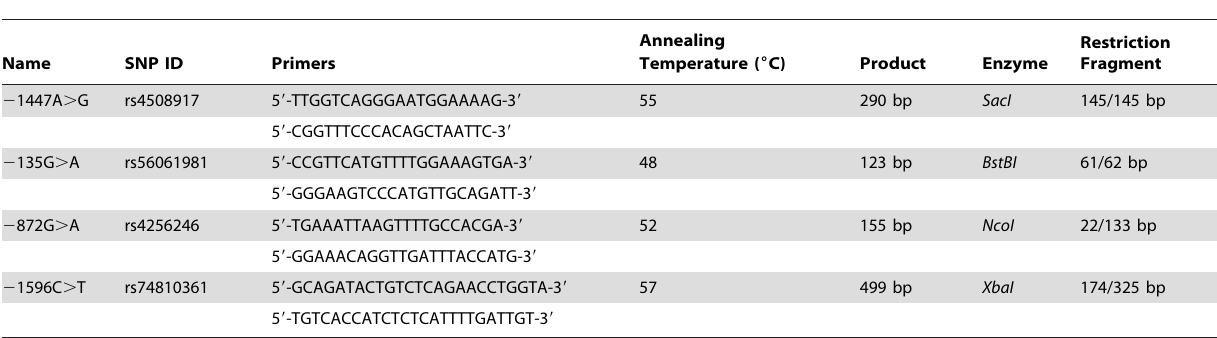
Table 7. List of Promoter Single Nucleotide Polymorphisms